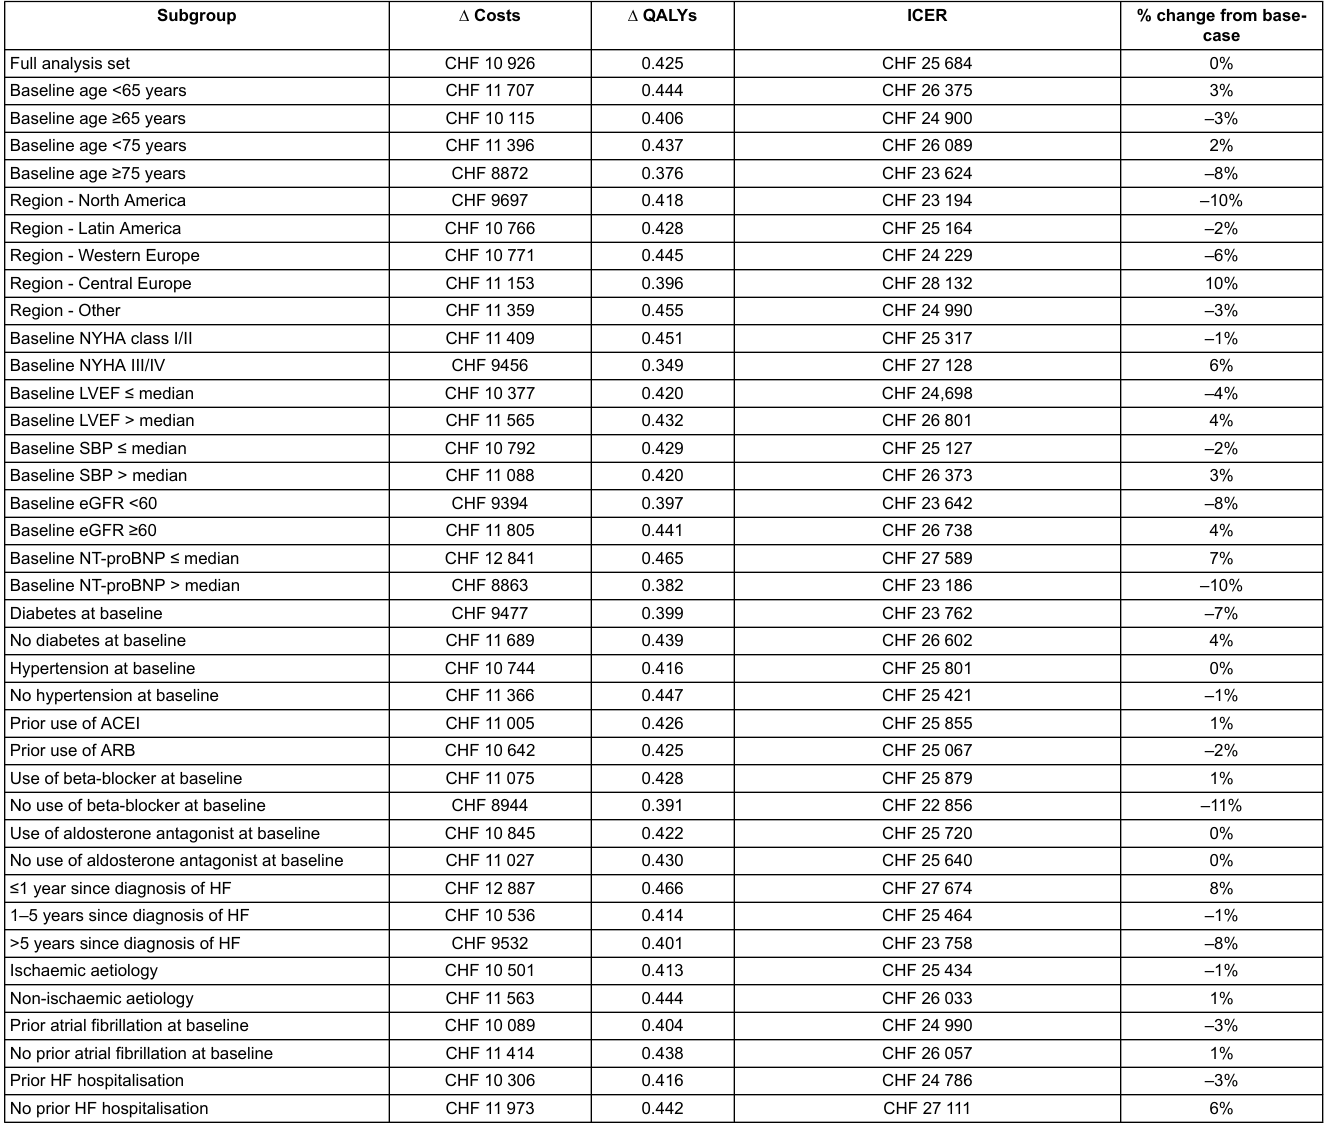
Table S13: Results of subgroup